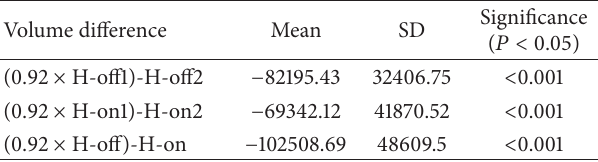
Table 7: Mean, standard deviation, and significance of one layer of